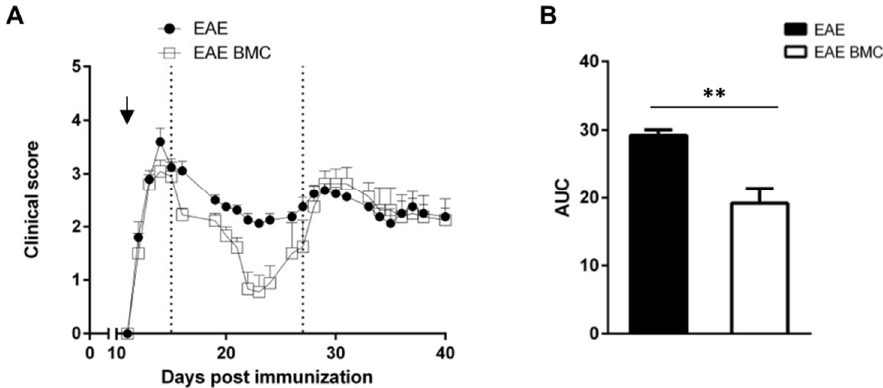
Figure 1. Mice treated with HSCs after intense immunosuppression develop milder EAE than their untreated counterparts only during the first relapsing-remitting phase. ( A ) EAE course of mice untreated or irradiated and treated with BMC. A representative example of two independent experiments is presented (total mice tested per group in two experiments n = 21). The arrow indicates the day when treatment was performed. Data are shown as mean ± SEM daily clinical score. ( B ) Quantification of the area under the curve (AUC) corresponding to the first relapse (days 15 to 27 after disease induction, as delineated by the two dotted lines on panel ( A ) during the course of the disease). Data are shown as mean ± SEM. ** p < 0.01.